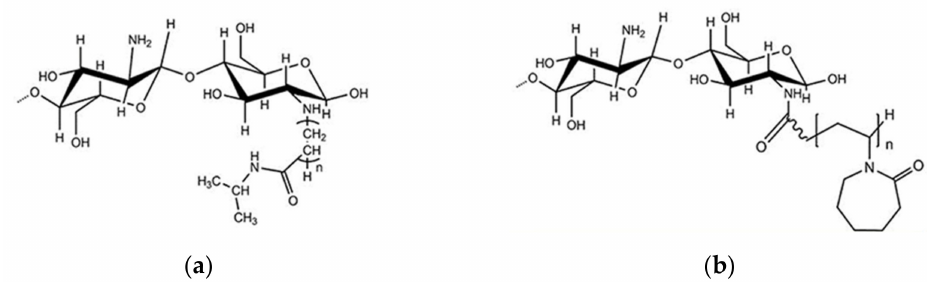
Figure 9. ( a ) Chemical structure of chitosan- graft -poly( N -isopropylamide). ( b ) Chemical structure of chitosan- graft -poly( N